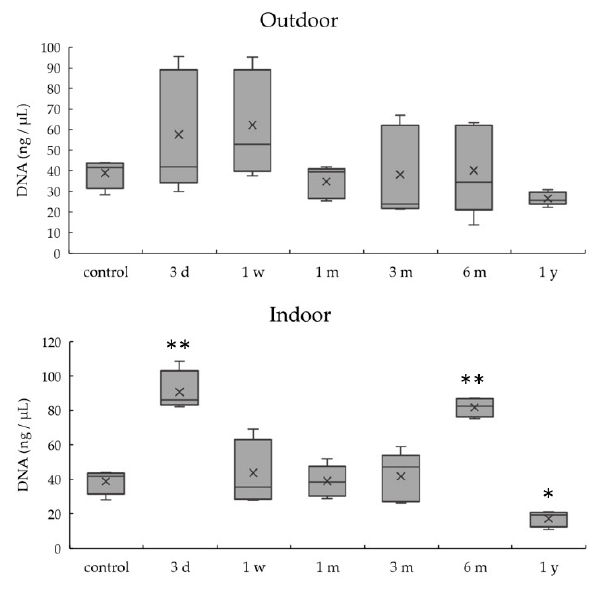
Figure 5. DNA quantitation by the absorbance method under five environmental conditions for 1 year. Means and standard deviations are presented. * p < 0.05 vs. control, ** p < 0.01 vs. control.